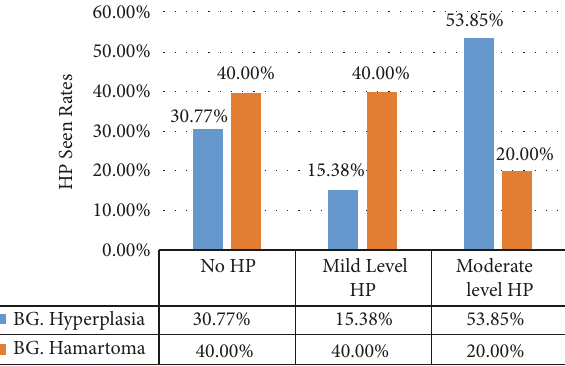
Figure 3: Presence of Helicobacter pylori (HP) in the proliferative lesions of Brunner’s gland (BG).